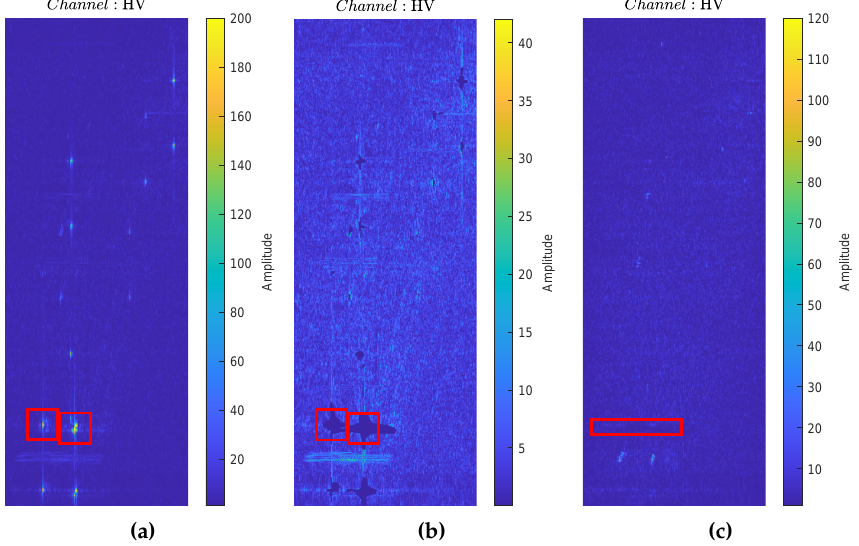
Figure 6. Simulations of the acquired HV polarized images with azimuth ambiguities of strong HH polarization based on parameters in Table 1. HH polarized data are simulated using chirp signals chirp of up modulated rate. HV polarized data are simulated using chirp signals chirp of down modulated rate. Vertical is the azimuth direction. ( a ) Acquired HV image using filter matched to up chirp, in which the desired HV polarized component is smeared with HH azimuth ambiguities focused (e.g., the focused targets in red rectangle). ( b ) Smeared HV image, in which the focused HH azimuth ambiguities has been removed by simply setting several pixels to zero according to the amplitude level in image (image sharpness and contrast). ( c ) Refocused HV image, which is obtained by focusing the inverse-focused data (after inverse imaging process), using corresponding filter matched to the down chirp. The content in red rectangle can be compared with that in Figure 5b, showing a decent ambiguity suppression